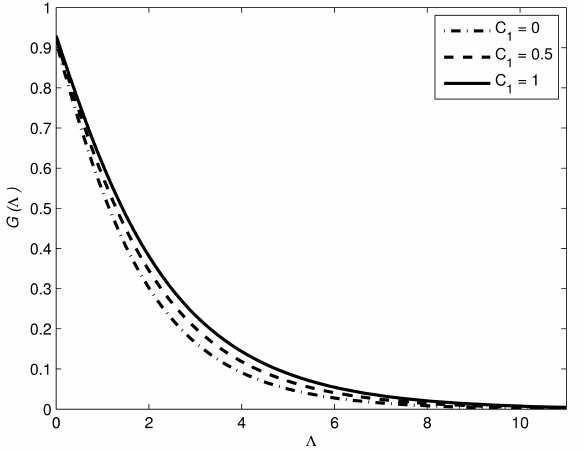
Figure 4: Effect of C 1 on − H ( Λ ) keeping ζ = η = 0.2 , C 2 = C 3 = 1 , Pr = 6.8 , Br = 1 and Re = 2950